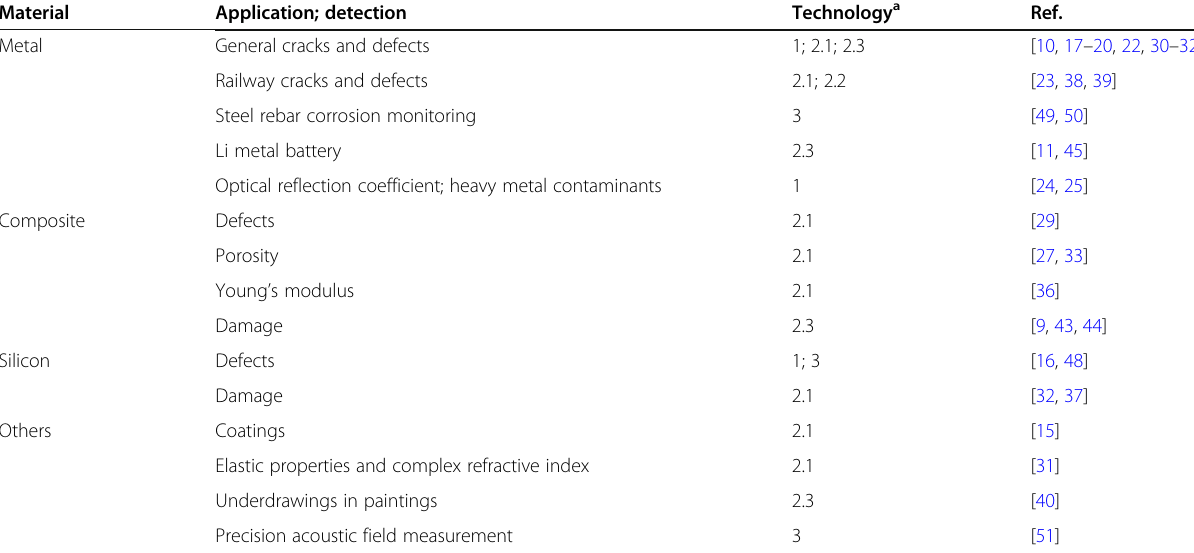
Table 3 Summary of the materials and applications by PA technologies for NDT/E Material Application; detection Technology a